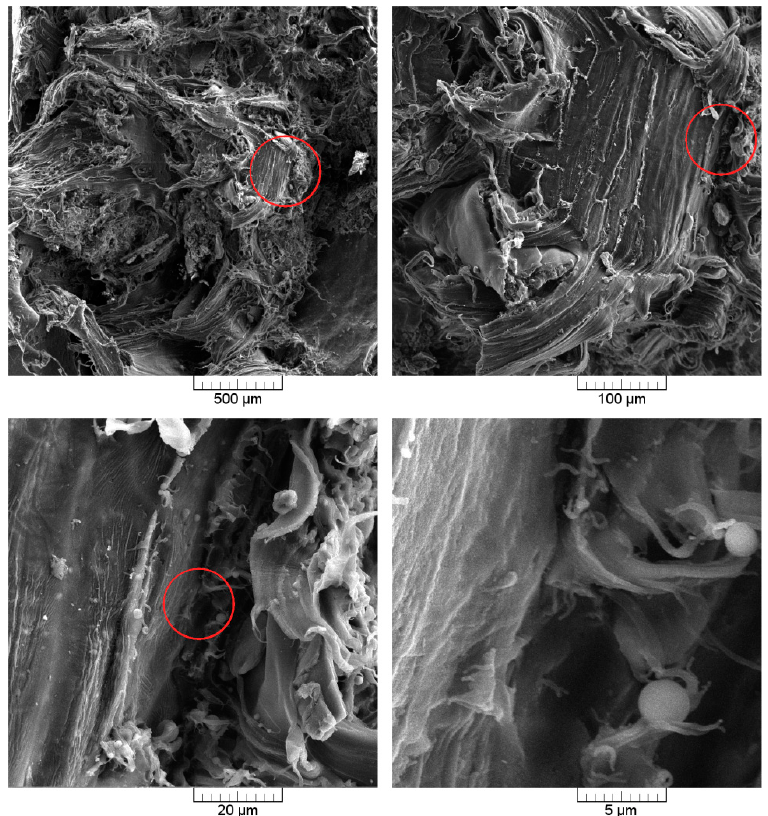
Figure 6. SEM images of 20% WB composite cross-section, taken with different magnifications.